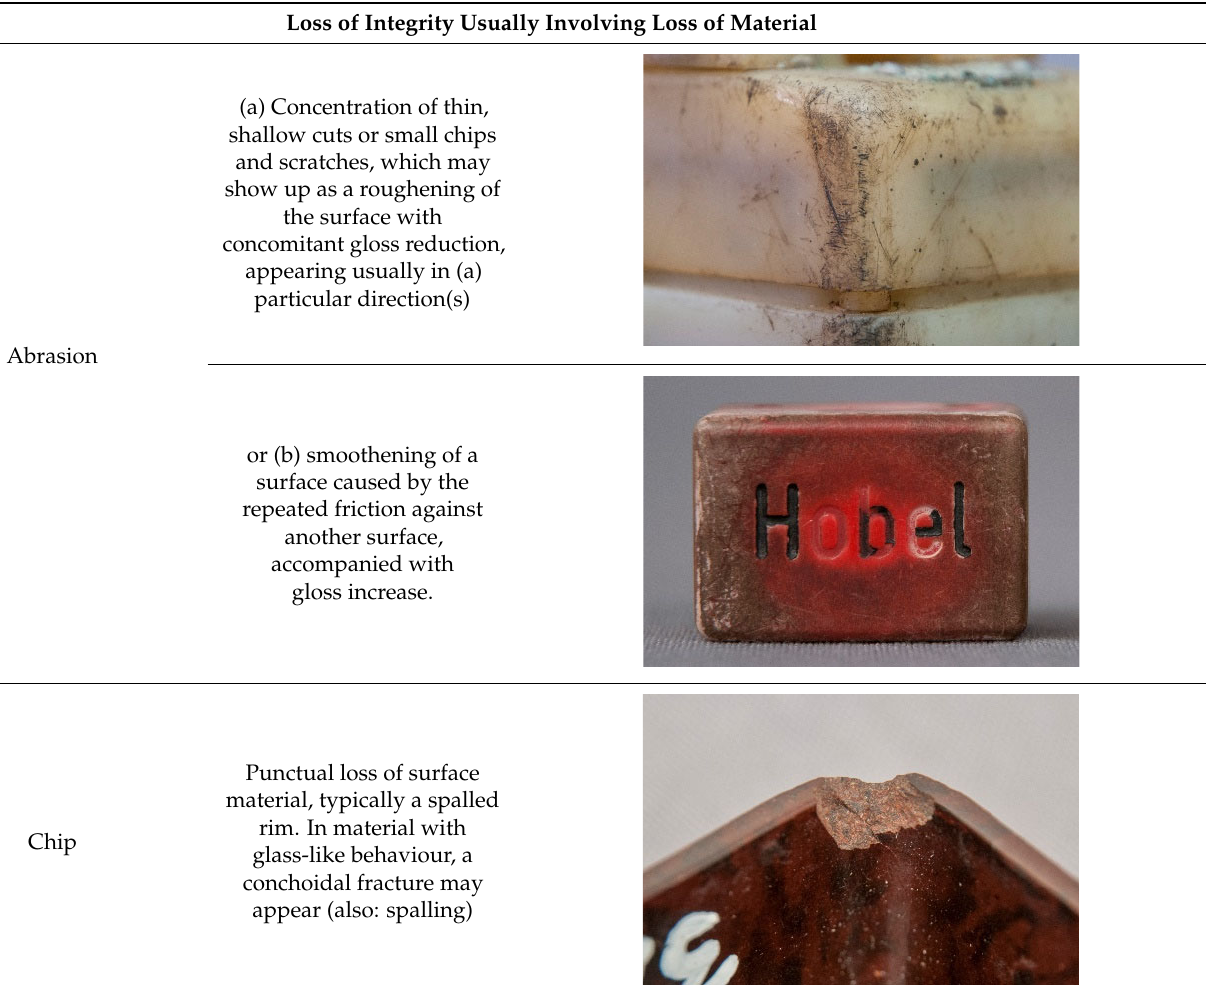
Table 5. Definitions of the subcategory ‘loss of integrity usually involving loss of material’.